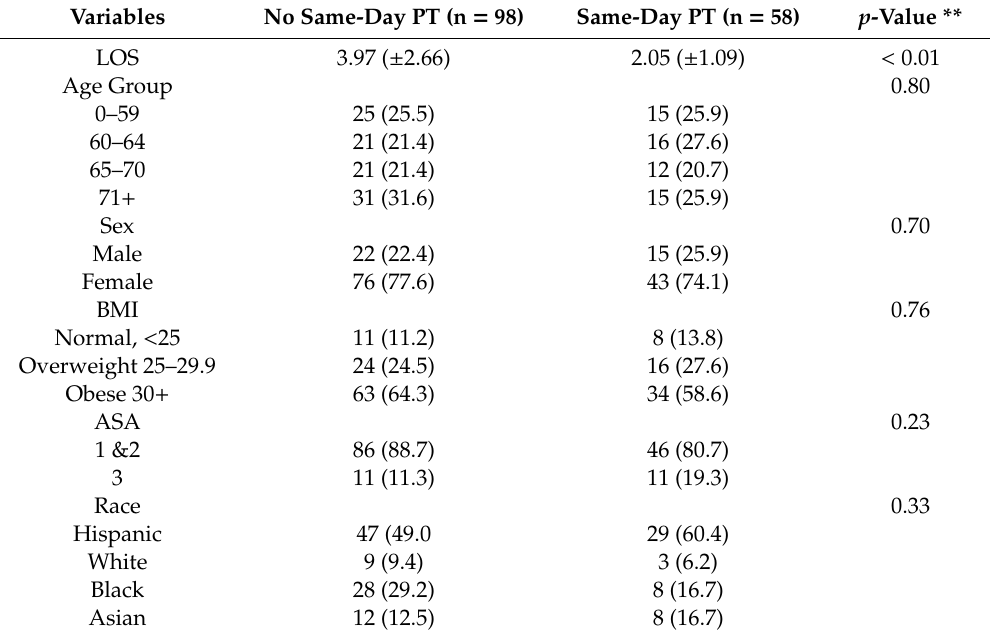
Table 2. Bivariate comparisons of length of stay and patient characteristics by same-day PT, represented as counts (%) or mean ( ± SD)